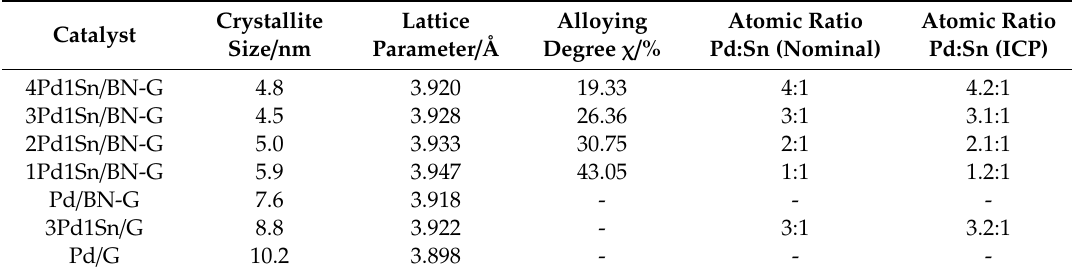
Figure 2. ( a ) TEM image of 3Pd1Sn / BN-G (inset: its corresponding particle size distribution), and ( b ) High Resolution Transmission Electron Microscope (HRTEM) image (the inset: an individual alloy nanoparticle with the lattice spacing of 0.23 nm), ( c – h ) High-Angle Annular Dark Field- Scanning Transmission Electron Microscope (HAADF-STEM) image and the corresponding elemental mapping images. Table 1. Physicochemical parameters of as-prepared catalysts.